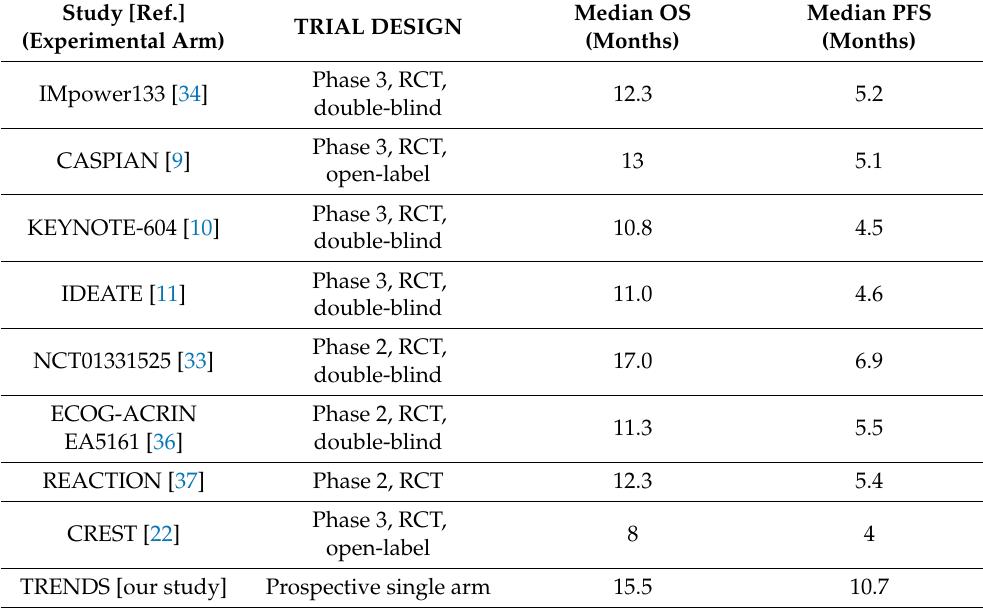
Table 3. Comparison between major I-line immuno-chemotherapy trials and thoracic consolidation studies in ED-SCLC. Study